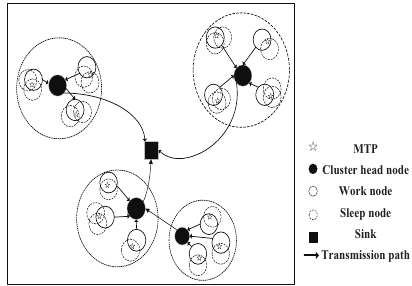
Figure 2. Network structure